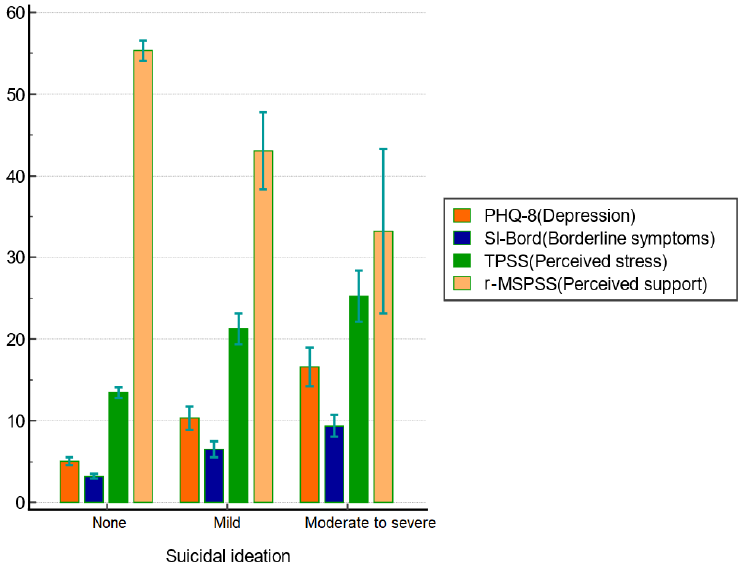
Figure 1. Clustered bar graphs illustrating mean and confidence interval for each group using a bar chart with error bars. r-MSPSS = Revised Thai Multidimensional Scale of Perceived Social Support, PHQ-8 = Patient-Health Questionaire-8, SI- Bord = Short Instrument for Borderline Personality Disorder, T-PSS-10 Thai Version of Perceived Stress Scales. We further conducted a univariate regression analysis for each variable to determine what variables should be included in the multiple ordinal regression model. Finally, we selected age, number of years studying, academic major, as well as the total scores of SI- Bord, r-MSPSS, TPSS, and PHQ-8. Table 3 shows the univariable regression analysis results. All models fit the data well indicated by the nonsignificance of the Pearson chi-square test and the deviance test re- sults. The standardized regression coefficients ranged from 0.086 to 1.299. All except r- MSPSS exhibited positive associations with suicidal ideation. Table 3. Results of univariable ordinal regression analysis. Estimate S.E.